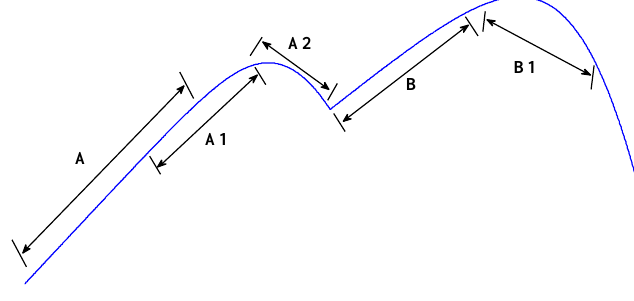
Figure 8. The possible location of new reference